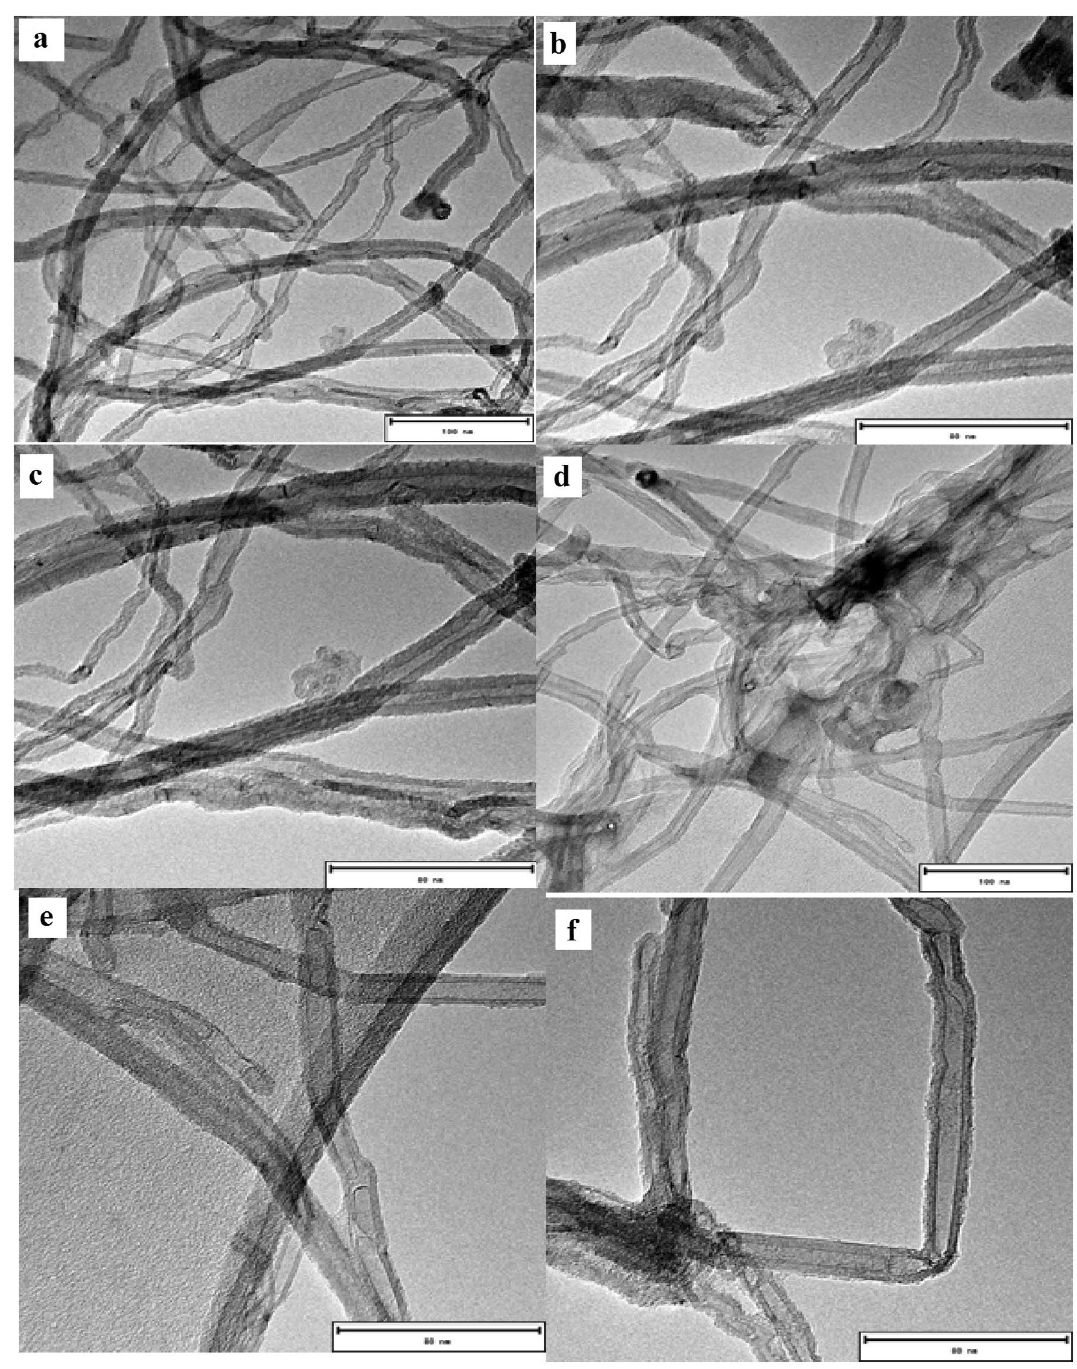
Figure 1. TEM micro images ( a ) Pristine CNTs at × 100 nm magnification ( b ) Pristine CNTs at × 80 nm magnification ( c ) Pristine CNTs at × 80 nm magnification ( d ) Functionalised CNTs at × 100 nm magnification ( e ) Functionalised CNTs at × 80 nm magnification ( f ) Functionalised CNTs at × 80 nm